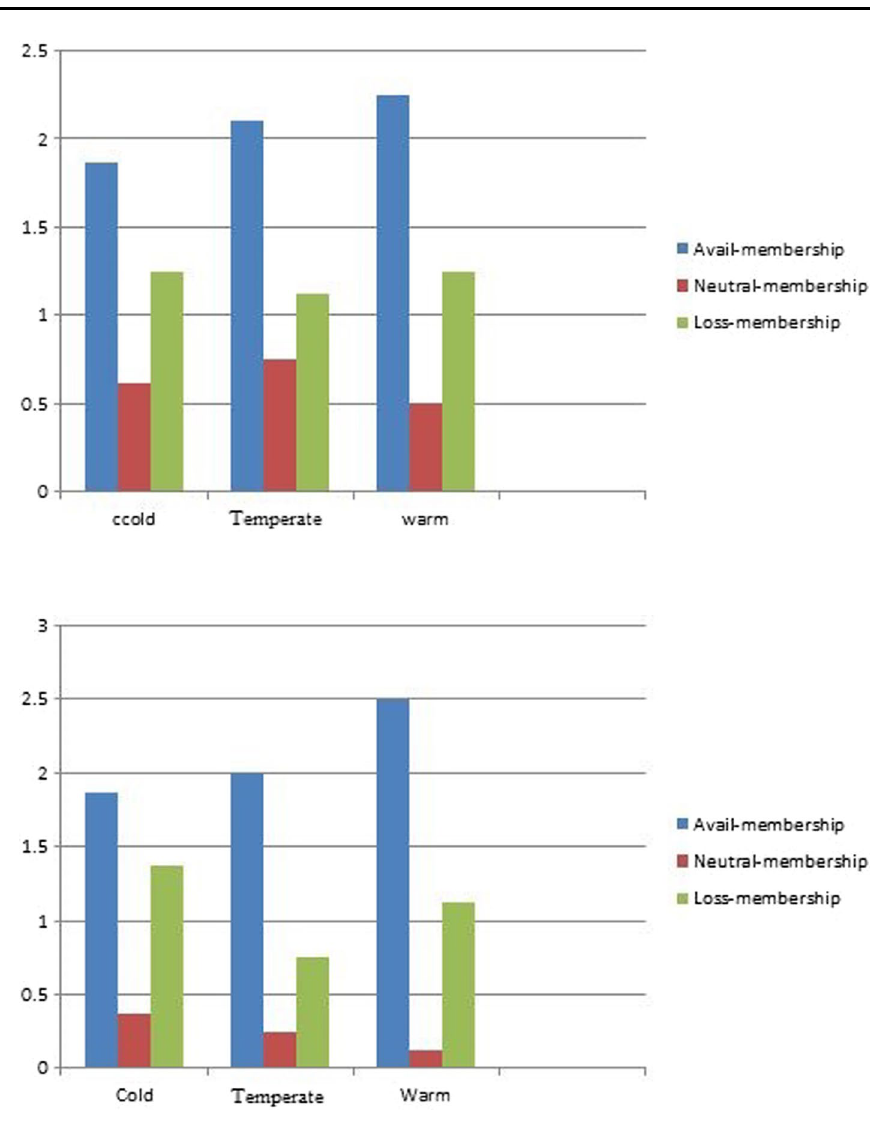
Fig. 10 Comparison of LEs of PFDGs